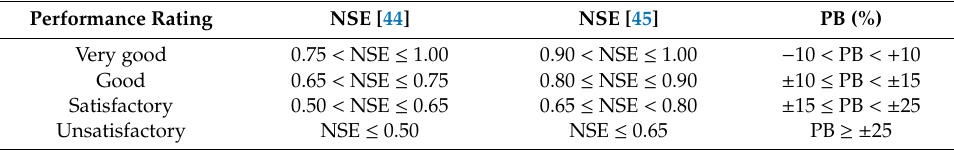
Table 2. Statistical indicators and associated performance ratings [44,45].